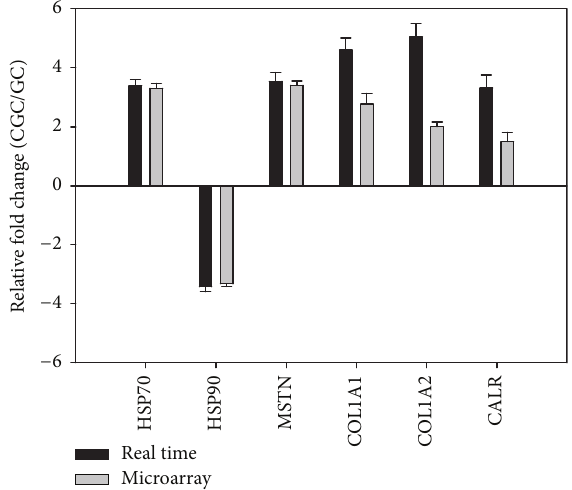
Figure 3: Quantitative real-time PCR confirmation of six differ- entially expressed genes identified by microarray analysis in crisp grass carp (CGC) versus grass carp (GC). Three samples were used for quantitative real-time PCR confirmation for experimental group and control group. 𝛽 -Actin gene was used as an internal control. HSP70 for heat shock cognate 70-kd protein, HSP90 for heat shock protein 90kDa alpha (cytosolic, B1), MSTN for myostatin, COL1A1 for type I collagen (alpha-1), COL1A2 for type I collagen (alpha-2), and CALR for calreticulin. Differential expression was determined by one-way ANOVA ( 𝑃 < 0.05